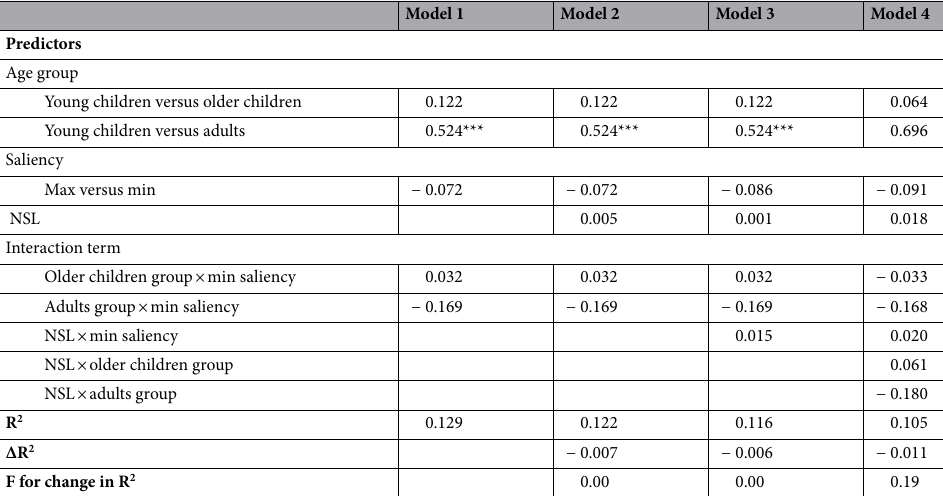
Table 5. Summary of the hierarchical regression analyses for variables predicting the ‘Metacognitive sensitivity’ index. Standardized regression coefficients (β) are reported for each predictor. The age group was presented as three dummy variables (young children, older children, and adults) with young children serving as reference group. The saliency condition was presented as two dummy variables (Max and Min) with Max saliency serving as reference condition. * p < .05, ** p < .01, *** p <